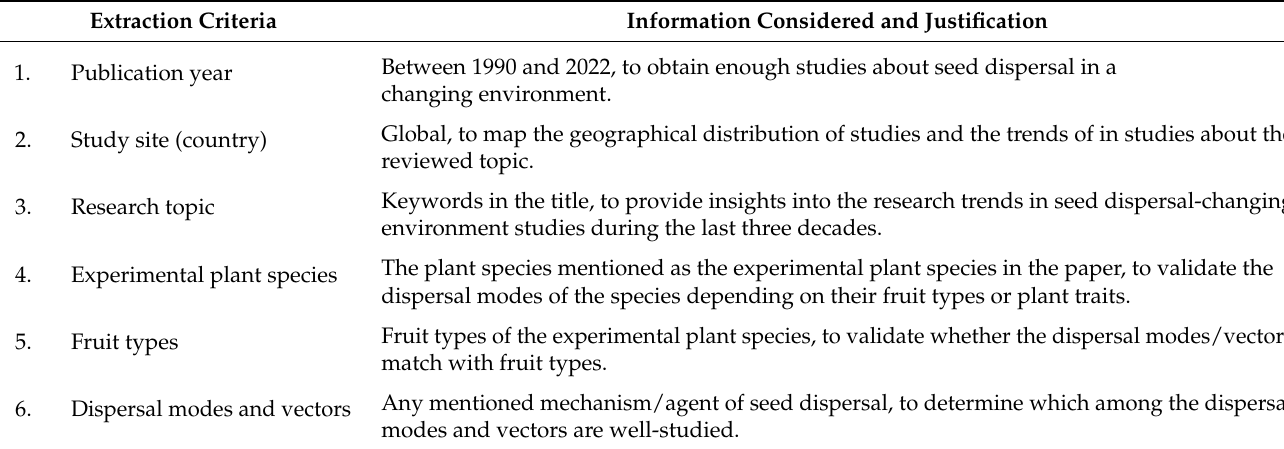
Table 4. The criteria used for the extraction of information from the selected peer-reviewed original articles published during the last three